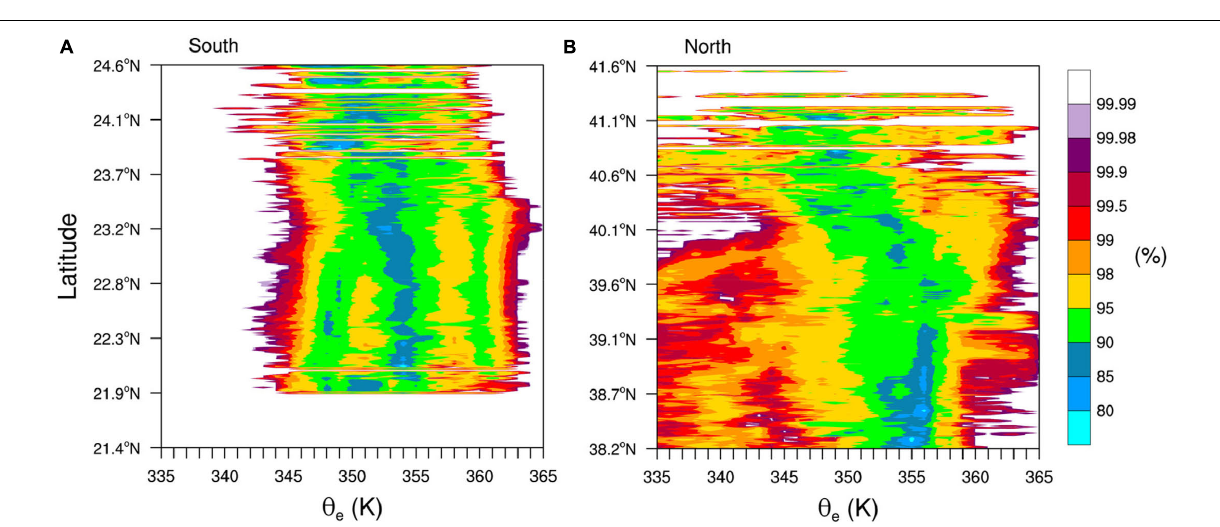
FIGURE 9 | The contoured frequency by latitude diagram distribution of equivalent potential temperature (K) (A) in south and (B) in